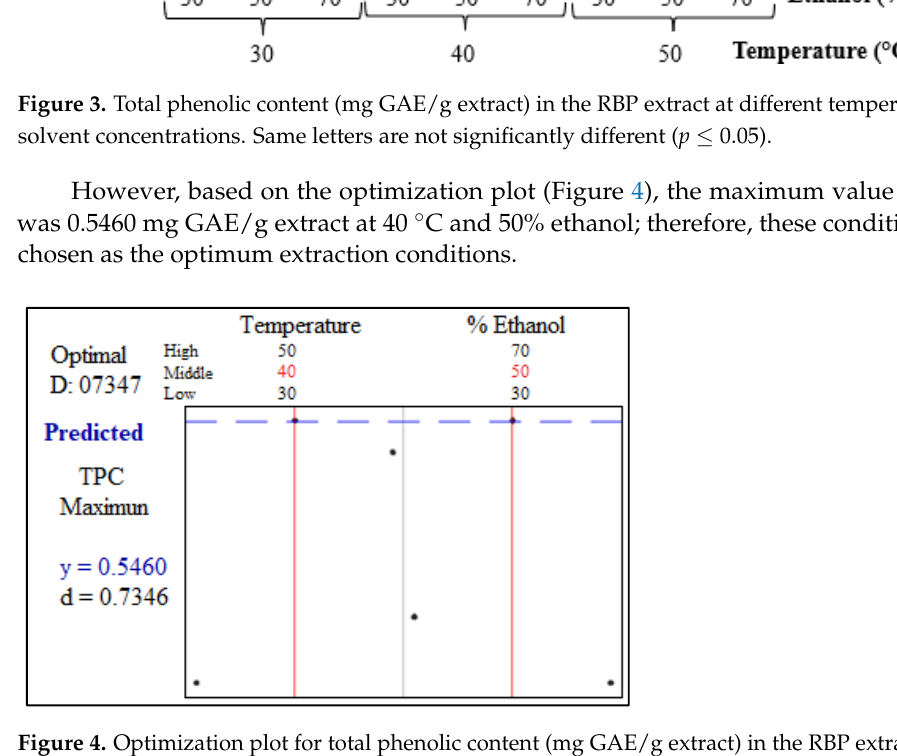
Figure 4. Optimization plot for total phenolic content (mg GAE/g extract) in the RBP extract at three temperatures (30, 40, and 50 °C) and three solvent concentrations (30, 50, and 70% v / v ).